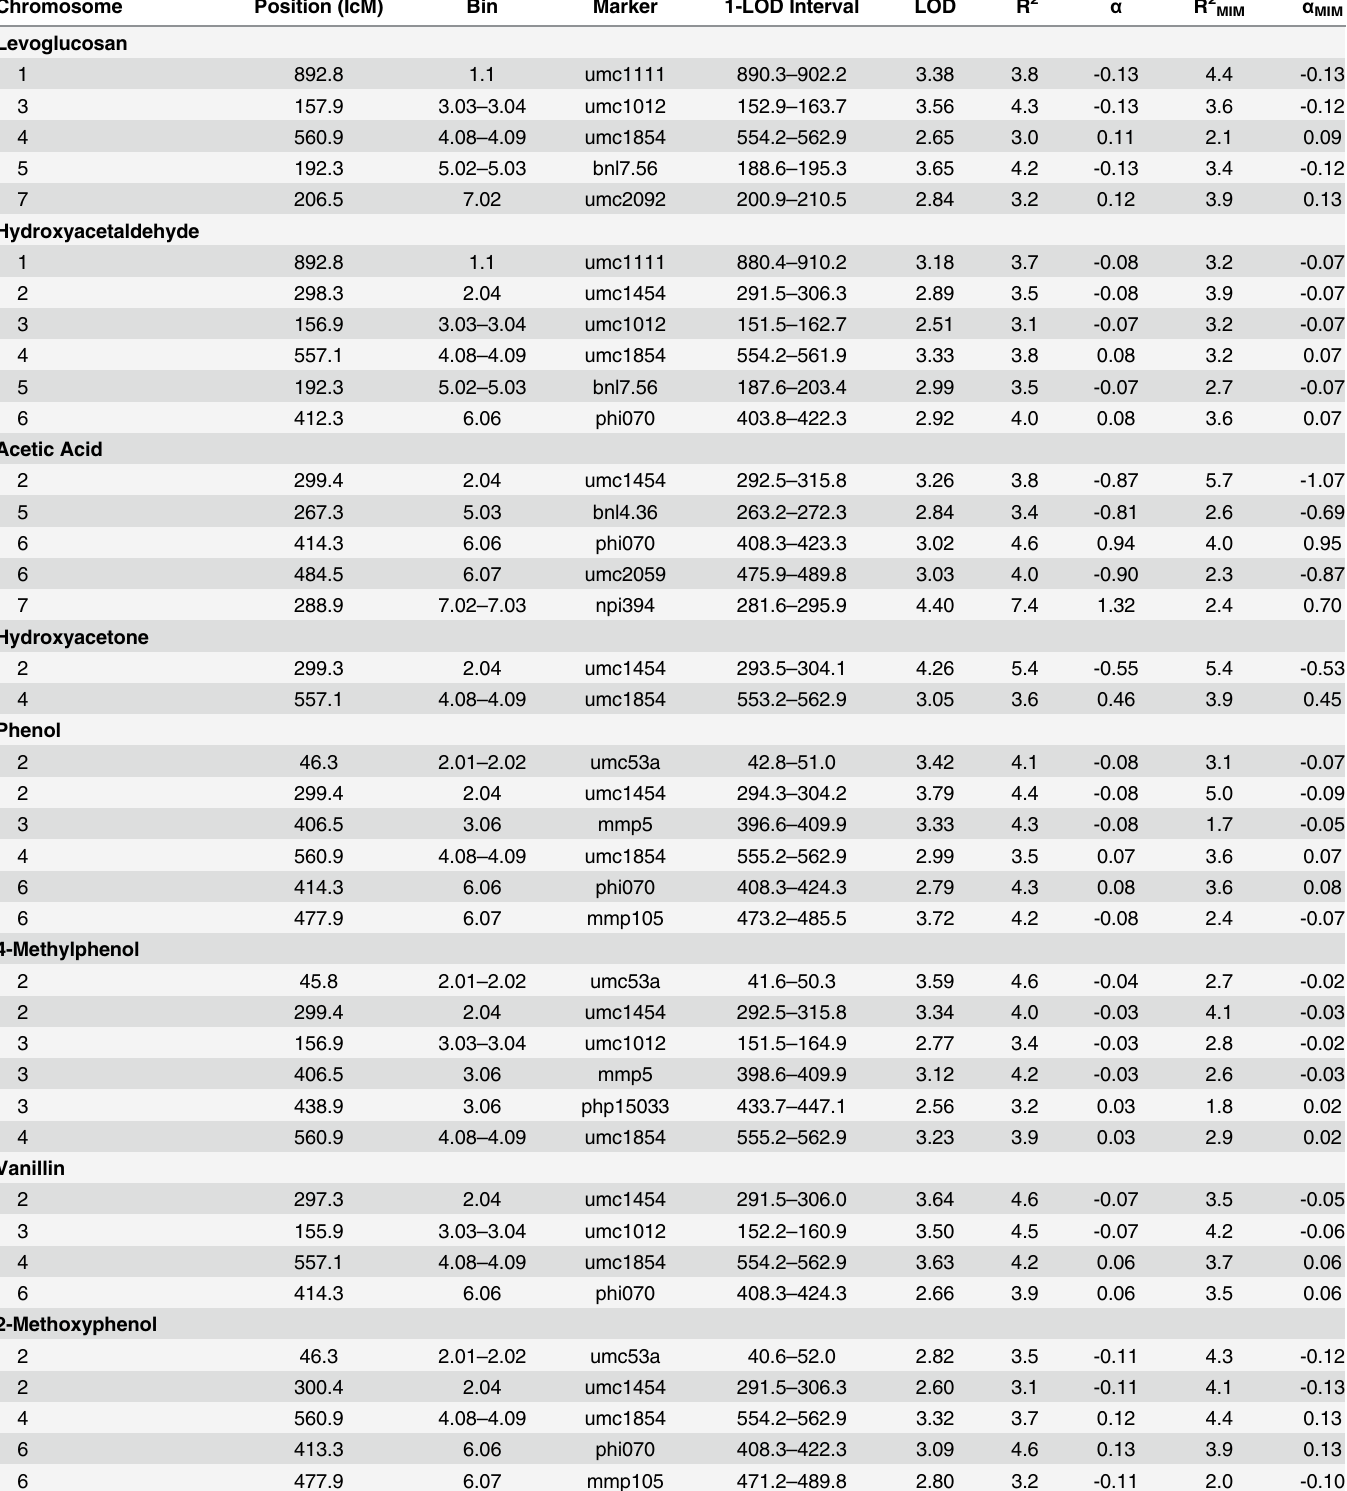
Table 3. QTL Positions and